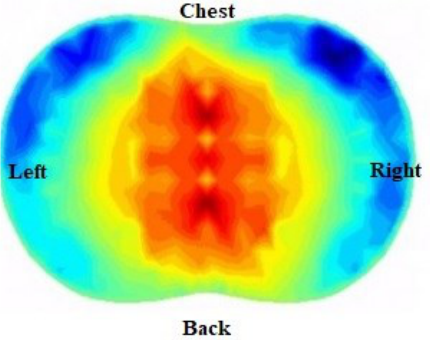
Fig. 3: Chest image reconstruction by EIT